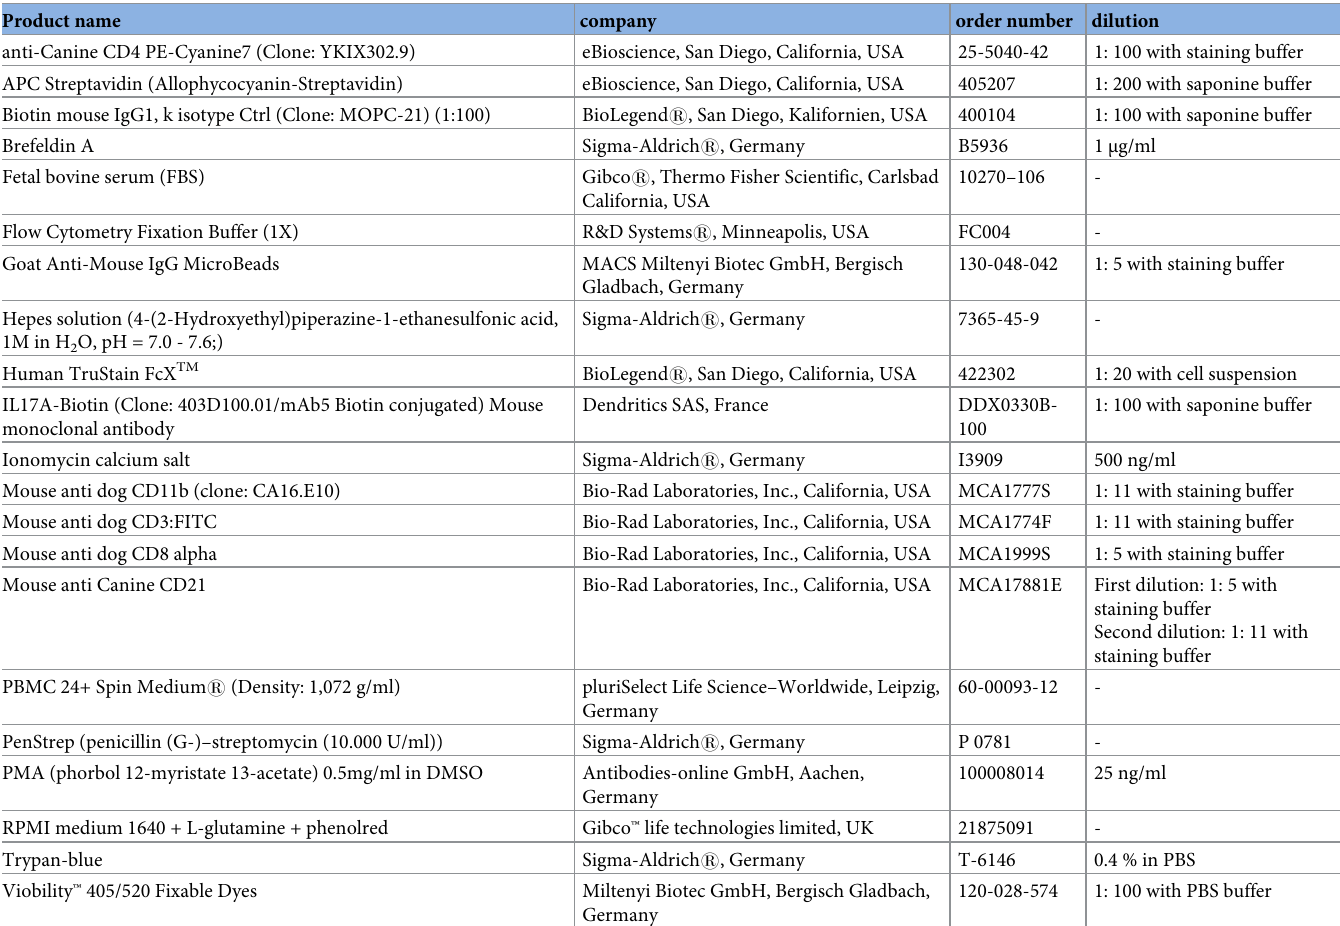
Table 1. Antibodies, solutions and buffer used for Th17-cell measurement by flow